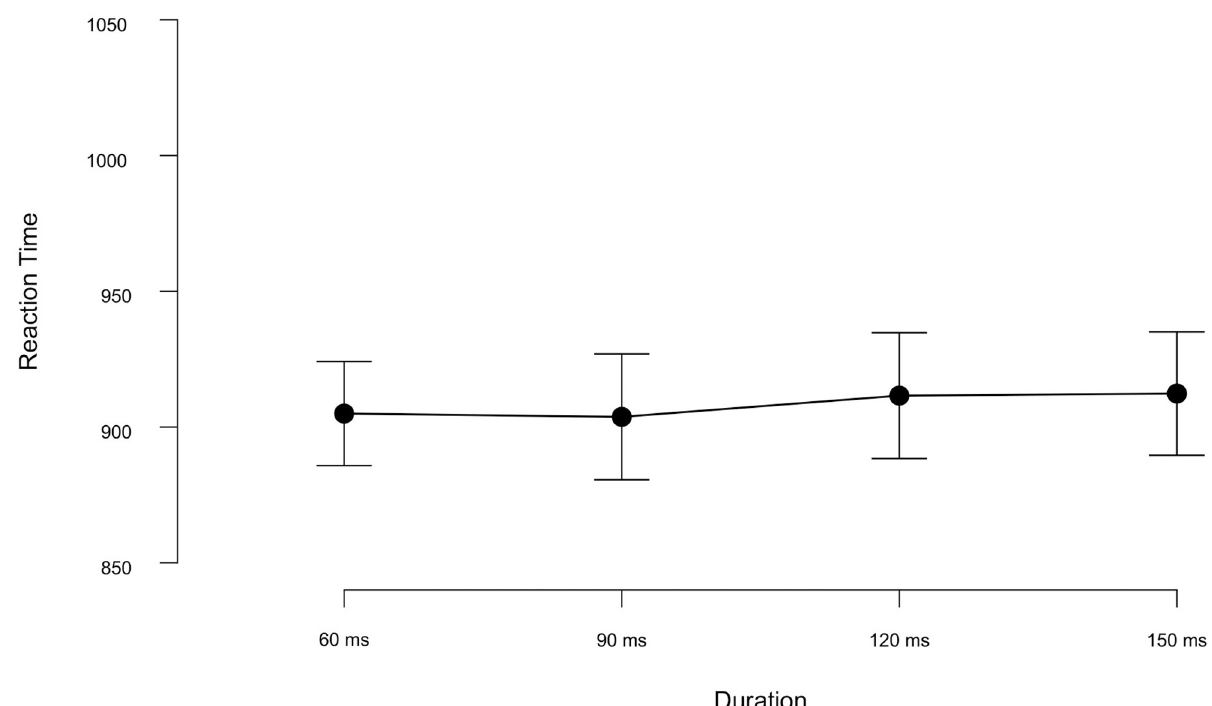
Fig 2. Reaction times (in ms) for target recognition as a function of stimulus duration for each item within each RSAP stream. Similar reaction times across all the duration conditions tested in Exp1a. Error bars represent the standard error of the mean.